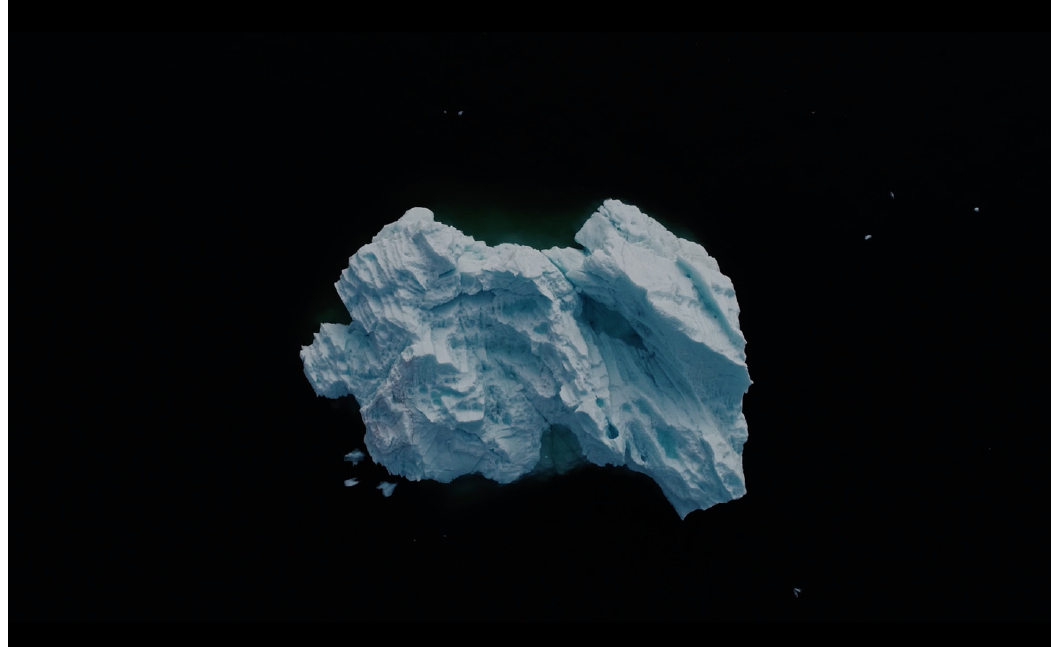
Figure 2: Rise: From One Island to Another . Source: Image courtesy of the